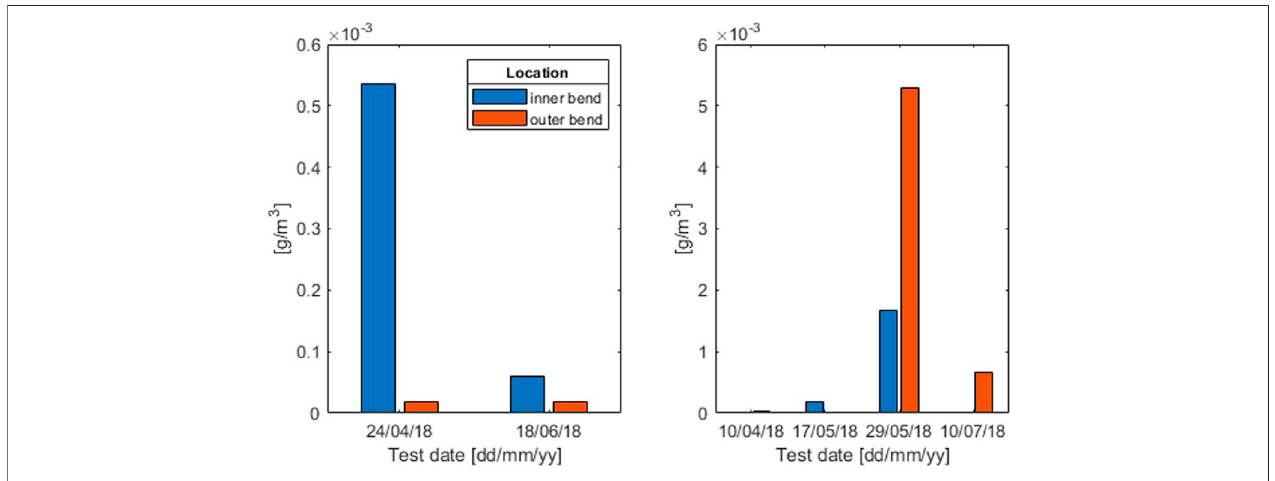
FIGURE 7 | Concentration of plastic litter at the surface both at the inner and outer bend for wind directions (left) from around south-west, and (right) from around north-east. Note the difference in